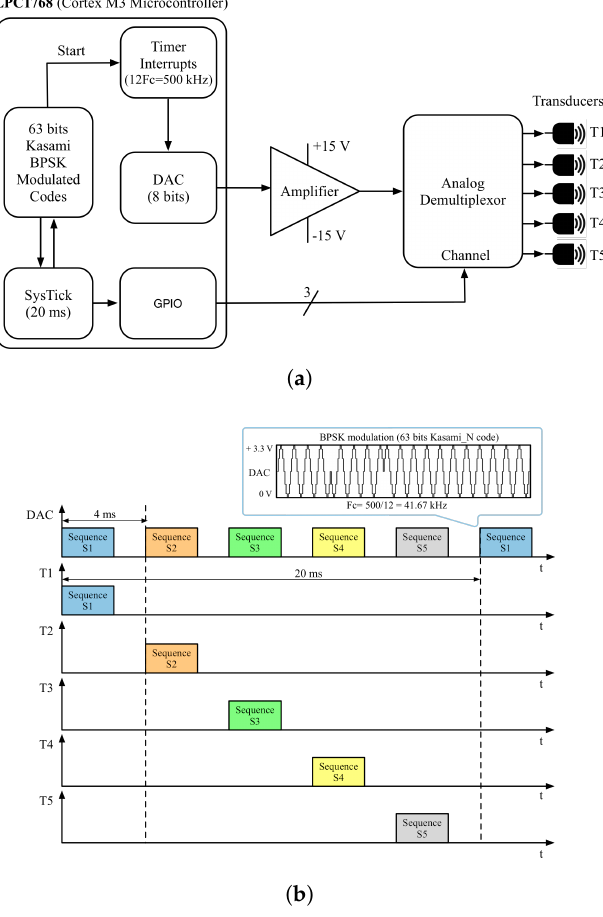
Figure 2. Ultrasonic emitter module, ( a ) Block diagram of the ultrasonic emitter module, ( b ) Beacons’ emission